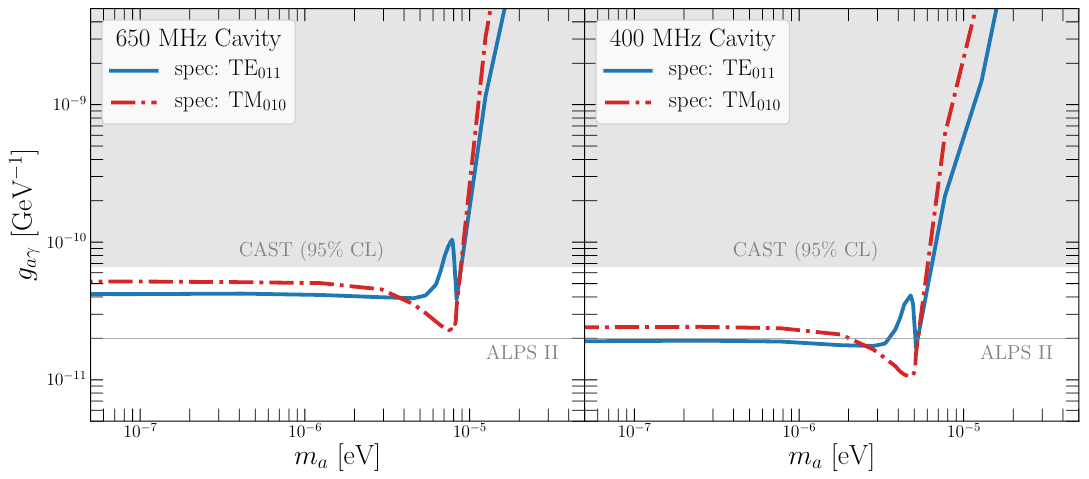
Figure 5 . SNR = 5 contours in the plane of g aγ vs m a , assuming E peak = 80MV / m , Q 1 = 10 10 , T = 1 . 4K , ∆ ω 1 = t − 1 , t int = 1year . The left (right) panel assumes cylindrical cavities with int R = L = 0 . 1766m (0 . 287m ), aligned in z with (0 . 1m + L ) between their centers. The red and blue contours correspond to the two setups in figure 3. Also shown are the limits that are established by CAST and projected by ALPS